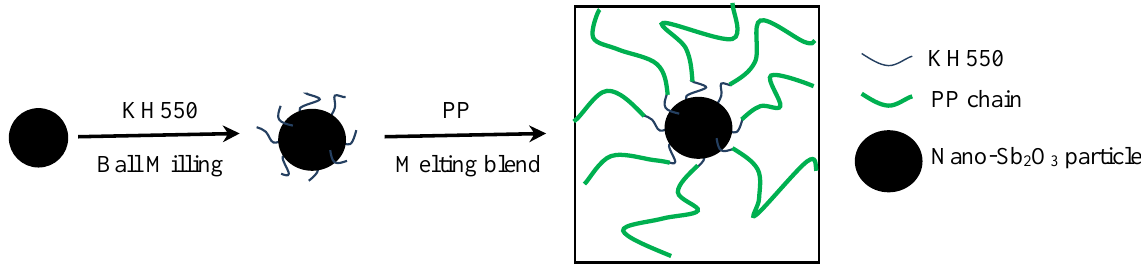
Figure 3: The schematic diagram of modification mechanism of nano-Sb 2 O 3 particles modified by KH550 and interfacial microstructure between nano-Sb 2 O 3 particles and PP matrix Table 2: The mechanical properties of PP and nano-Sb 2 O 3 /BPS-PP composites